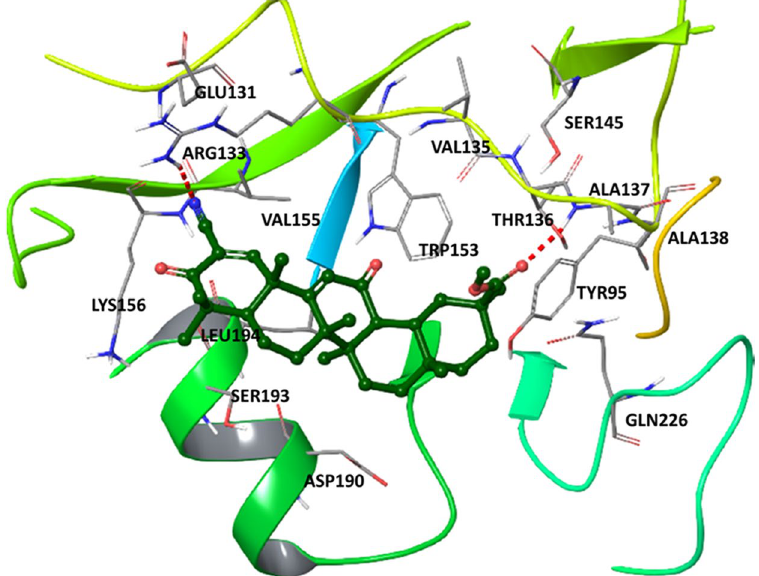
Figure 4. The docking complex of SM and hemagglutinin (PDB ID: 1RVT). SM is rendered as a stick and ball representation. Only residues situated less than 4 Å from the ligand has been shown. Hydrogen bonds between HA and SM are labeled as red.